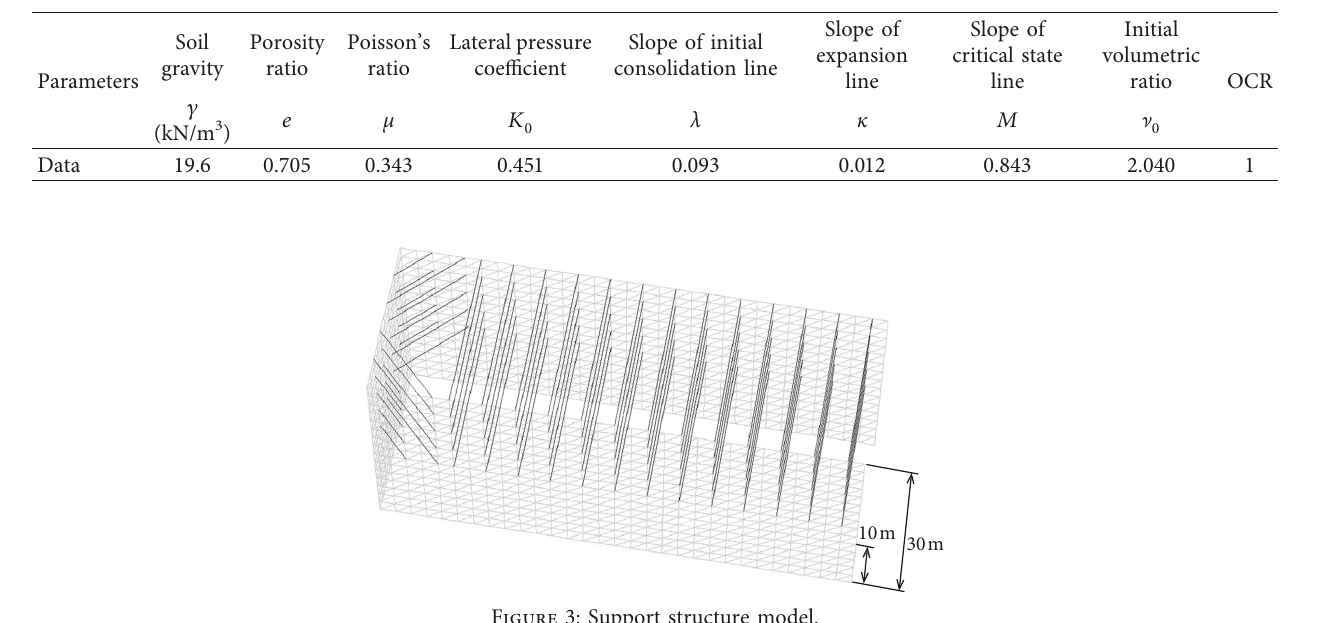
Figure 2: Soil-mass Table 1: Parameters of the clay soil.